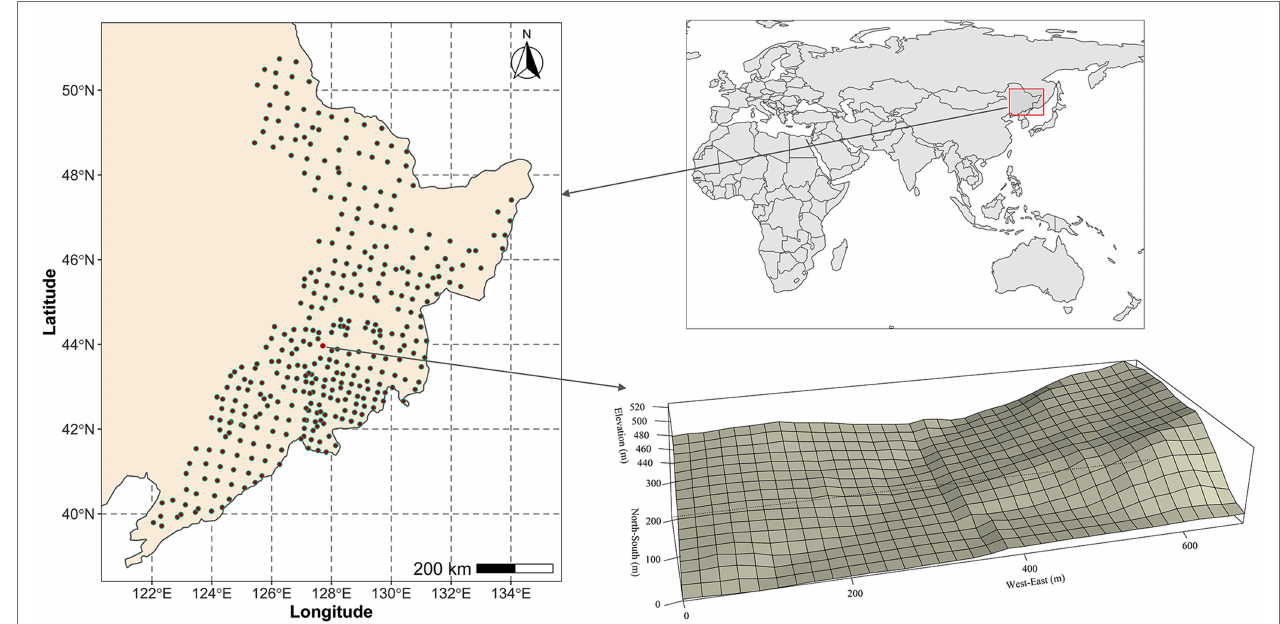
FIGURE 1 | Spatial distribution of the surveyed